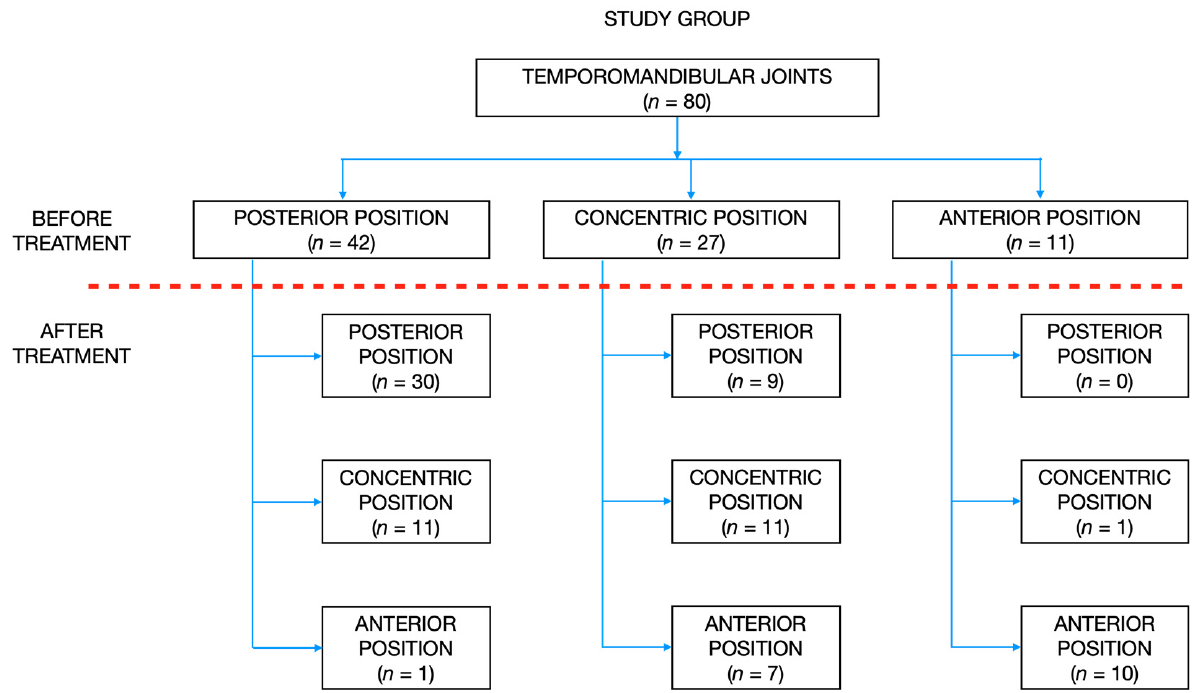
Figure 5. The distribution of condylar sagittal positions within the glenoid fossae in the study group before and after the treatment.